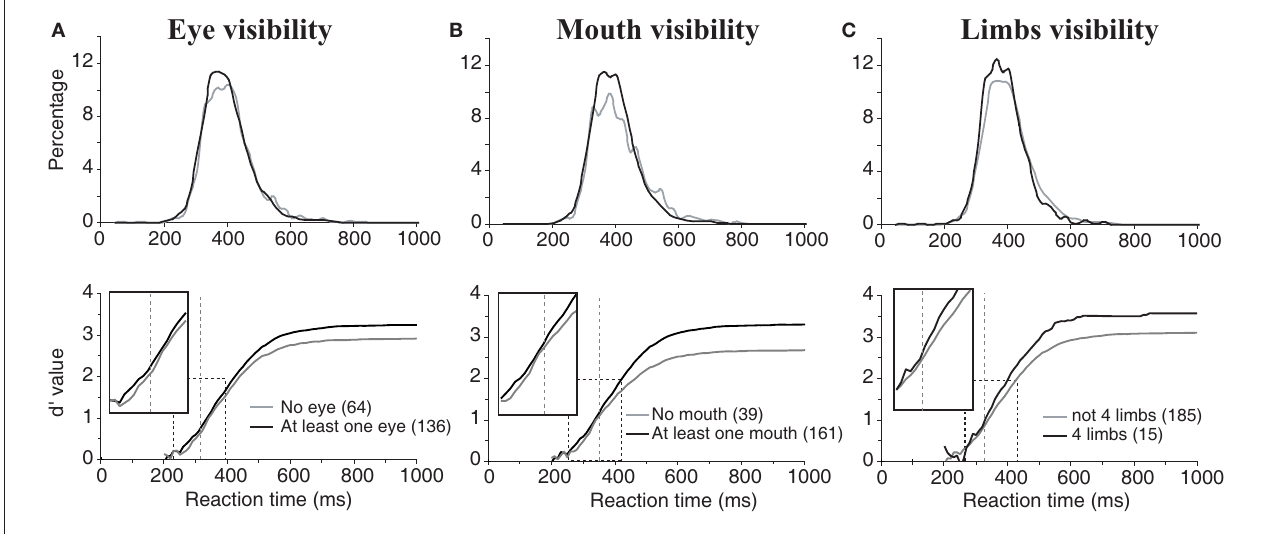
represented for the presence or absence of a given characteristic. Vertical dotted lines indicate the earliest latency at which the χ 2 test became significant (315 for eyes; 351 for mouths; 328 for four limbs). Boxes show close-up views of the d ′ curves within the dashed rectangles to better show the shift of the curves towards longer latencies in absence of the animal feature(s).